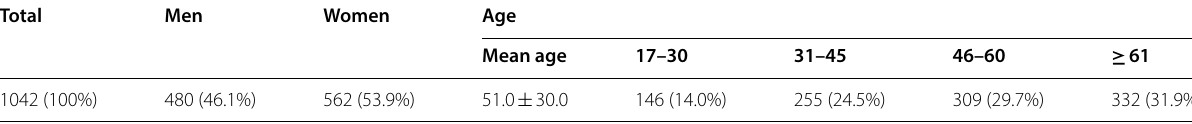
Table 1 Distribution of subjects included in the study according to sex and age